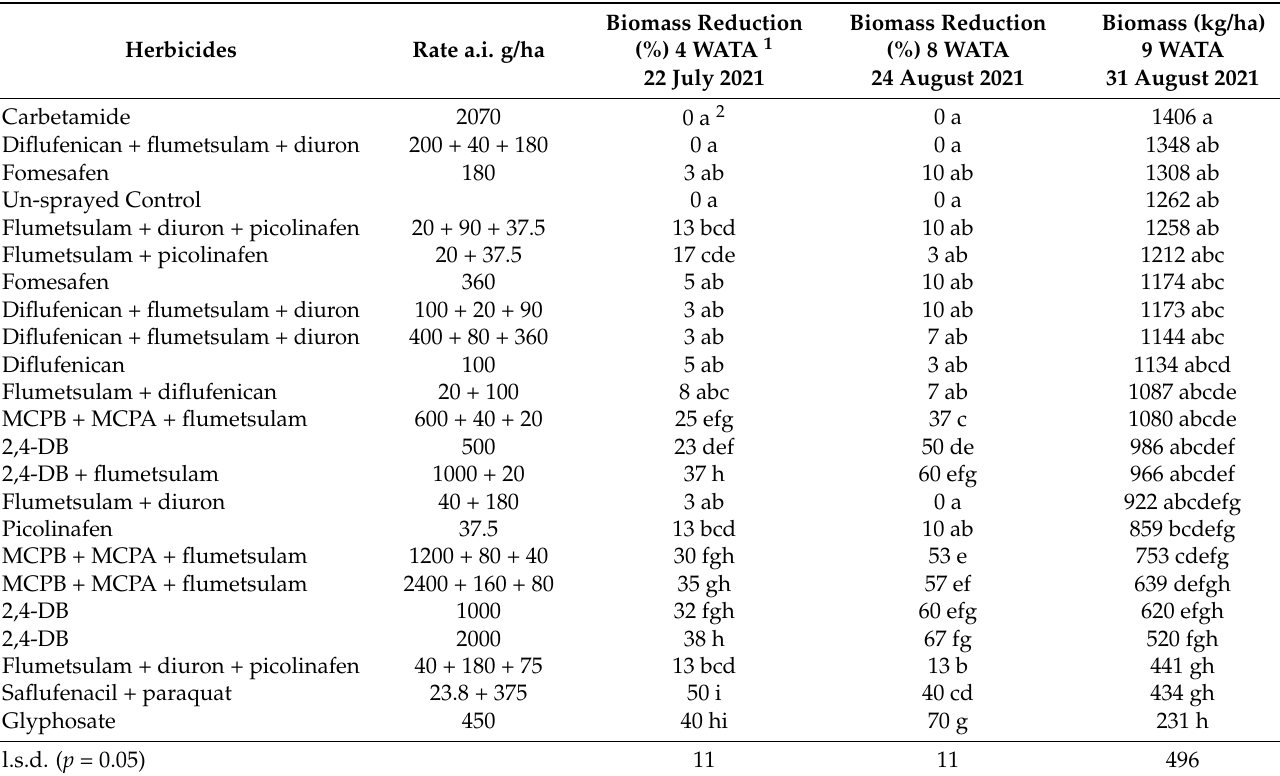
Table 13. Visual tedera biomass reduction in comparison with un-sprayed control 4 and 8 weeks after treatment application and biomass yield 9 weeks after 22 post-emergent herbicide treatment application at Dandaragan during